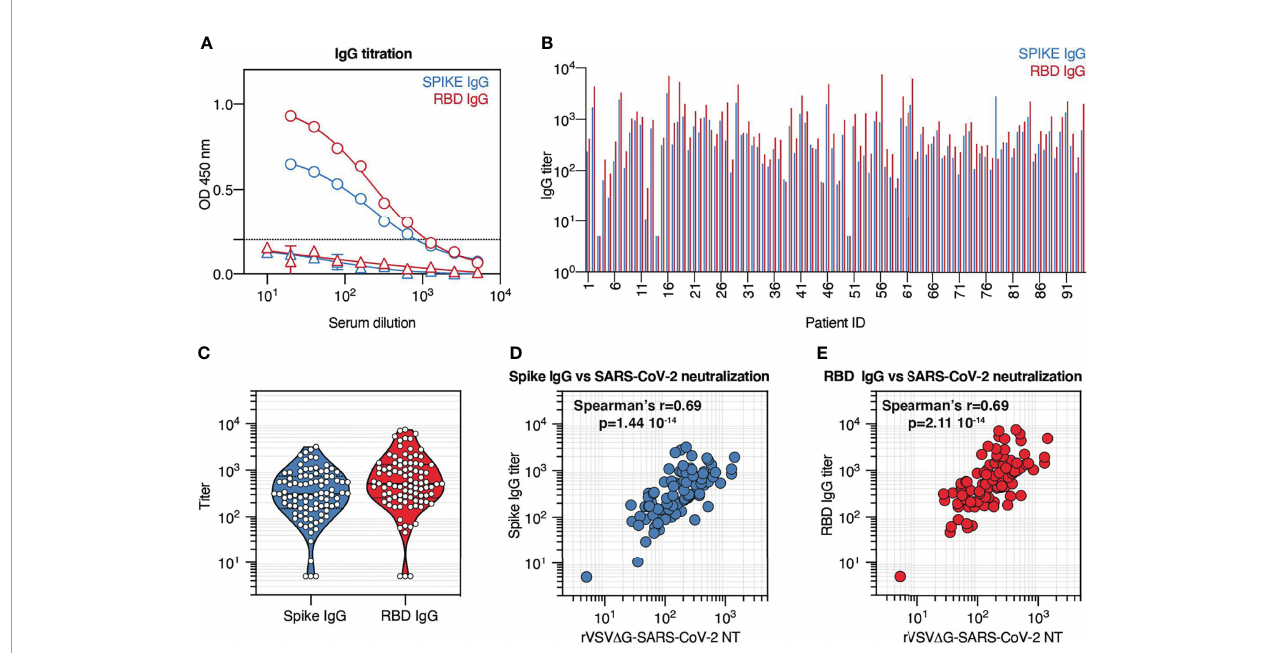
FIGURE 4 | Convalescent patient serum contains variable titers of anti-Spike and anti-receptor-binding domain (RBD) IgG antibodies that correlate with neutralization potency. (A) Spike and RBD IgG titration by ELISA across 10 serum sample dilutions. Representative data (mean ± SD) of a COVID-19 convalescent individual (circles) and a prepandemic serum sample (triangles) are shown. (B) Spike and RBD IgG titers in serum samples from the cohort. Results are displayed by patient ID. (C) Violin plot indicating Spike and RBD IgG titer distribution across the cohort. Each symbol represents one patient. (D) Correlation between serum neutralization titers obtained with rVSV D G-SARS-CoV-2 pseudotypes and Spike IgG titer across all patients from our cohort. (E) Correlation between serum neutralization titers obtained with rVSV D G-SARS-CoV-2 pseudotypes and RBD IgG titer across all patients from our